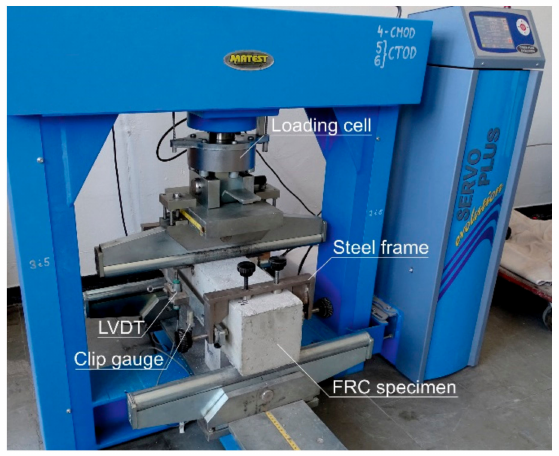
Figure 3. The flexural test of the FRC